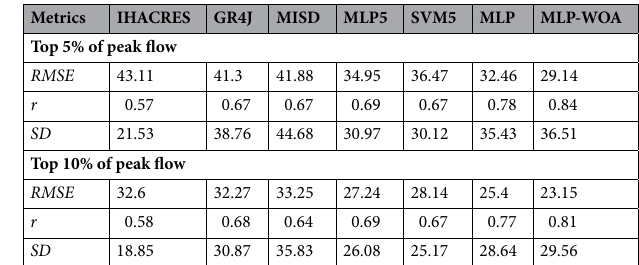
Metrics IHACRES GR4J MISD MLP5 SVM5 MLP MLP-WOA Top 5% of peak